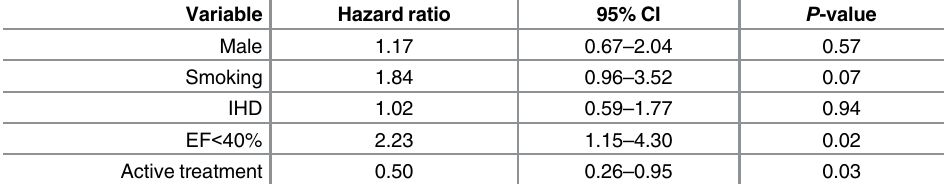
Table 2. Proportional hazard regression analysis of cardiovascular mortality in the study population with a basal selenium level < 65 μ g/L (mean value) during an intervention time of four